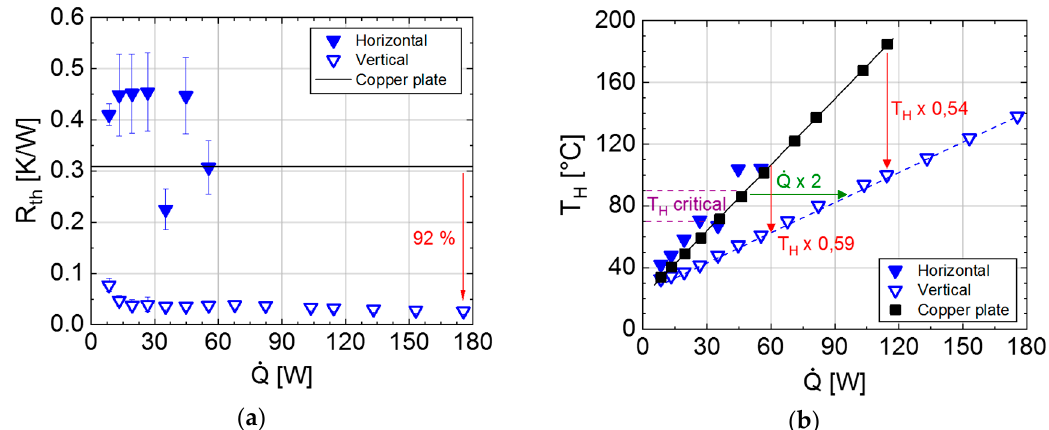
Figure 13. Results for PHPs with channel size of 1.5 × 1.5 mm 2 with air cooled heat sink, compared to a solid analogous copper plate. ( a ) Plot of thermal resistance R th vs. heating power ´ Q . Red arrow: reduction in R th compared to copper plate; ( b ) plot of heater temperature T H vs. heating power ´ Q . Results for horizontal and vertical orientation of the PHP with respect to gravity are given. Red arrows: heater temperature of heater on PHP relative to copper plate at the same heating power. Green arrow: heating power of heater on PHP relative to copper plate at the same temperature.